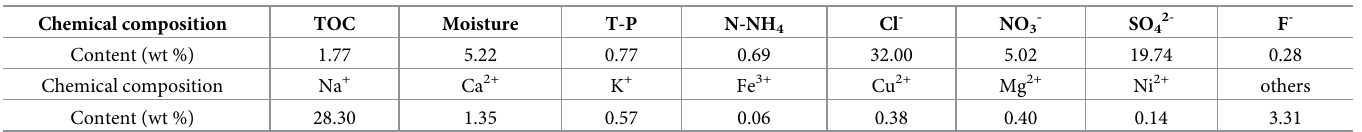
Table 1. The chemical composition of the industrial waste salt. Chemical